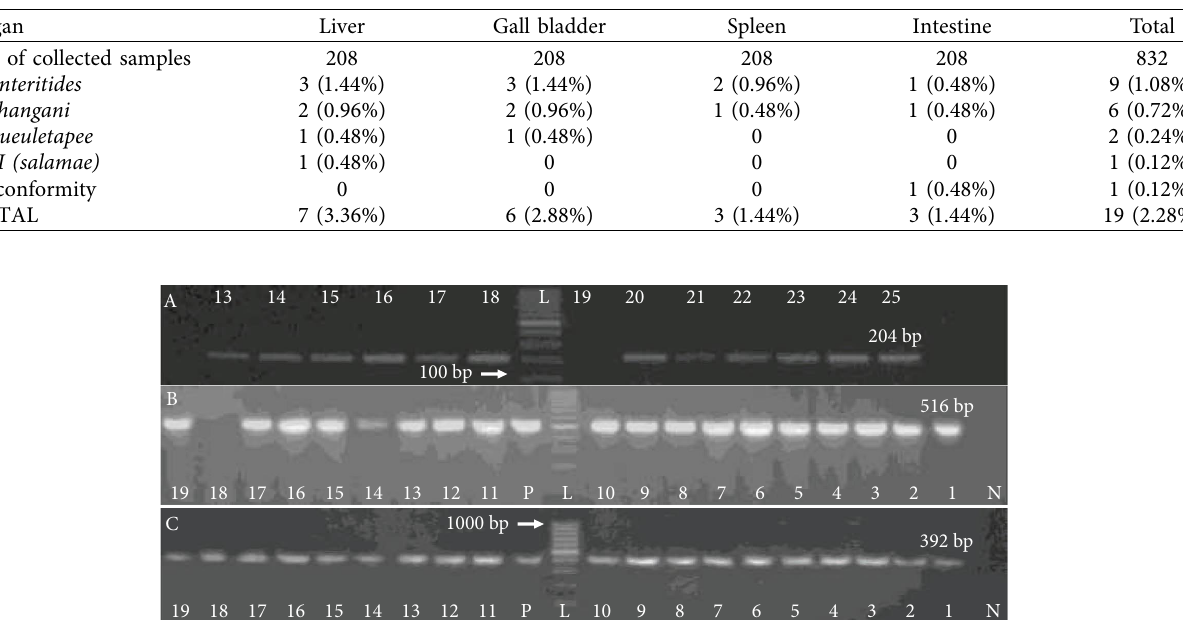
Table 3: Putative Salmonella spp. that was isolated from the organs of individual chickens.